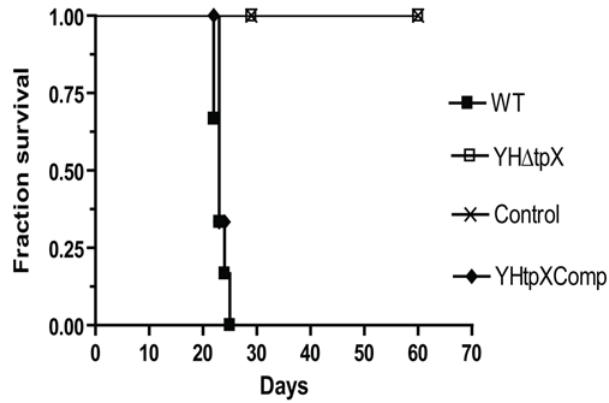
Figure 4. Survival of SCID mice ( n =6 per group) infected intravenously with M.tuberculosis H37Rv WT, YH D tpx and the complemented strains. Deletion of tpx gene led to no death of the mice over 60 days after infection.